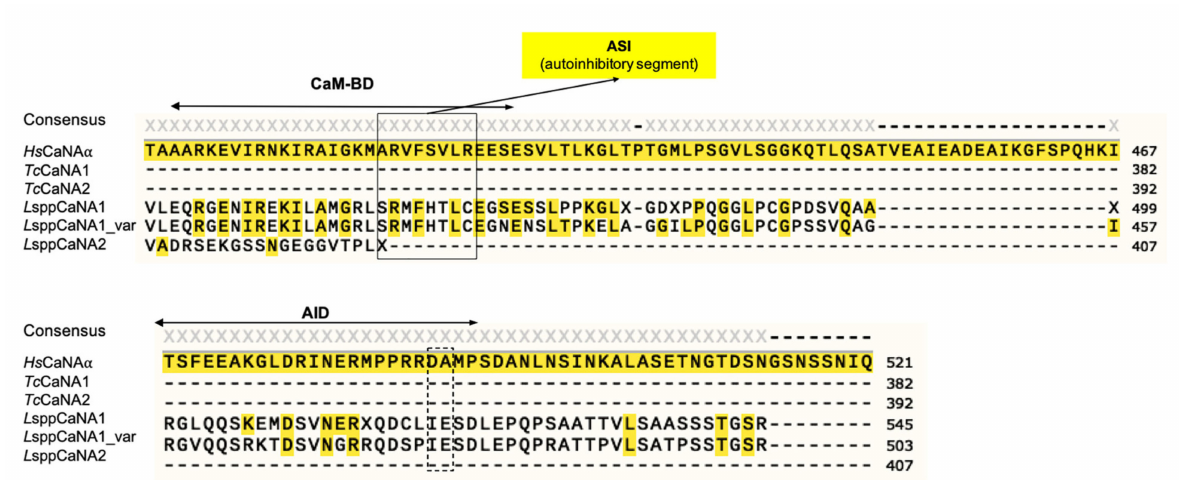
Figure 4. On top: CaM-BD sequence alignment present in CaNA. Underneath: AID sequence alignment present in